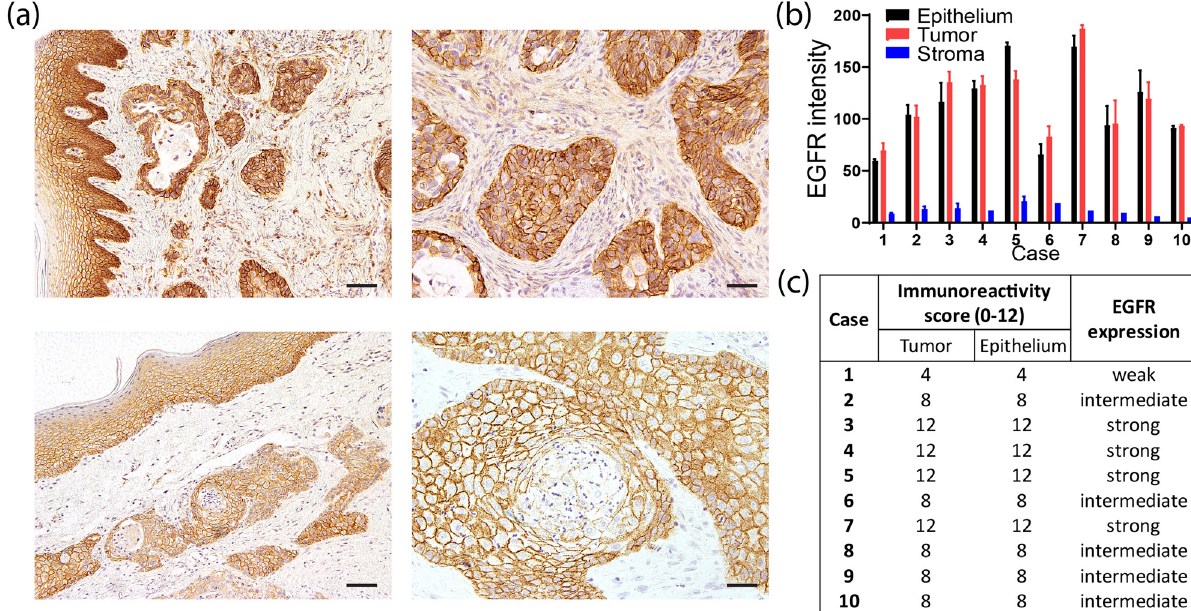
Figure 1: EGFR expression in feline OSCC and surrounding tissue. Immunohistochemistry was performed in 10 cases of OSCC with normal adjacent oral